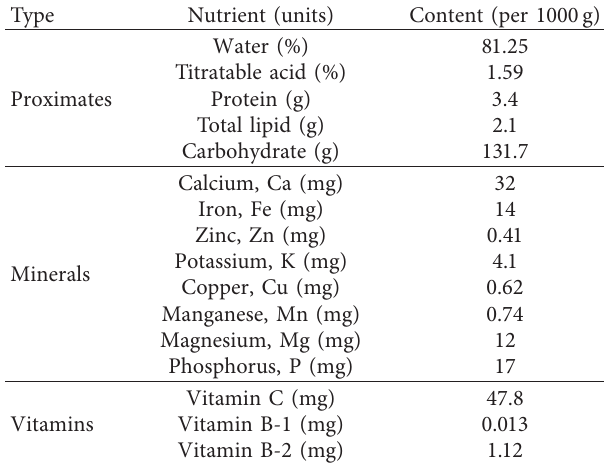
Table 1: Nutrient composition of Malus prunifolia fruits (adapted from Shanxi Food Industrial Research Institute)